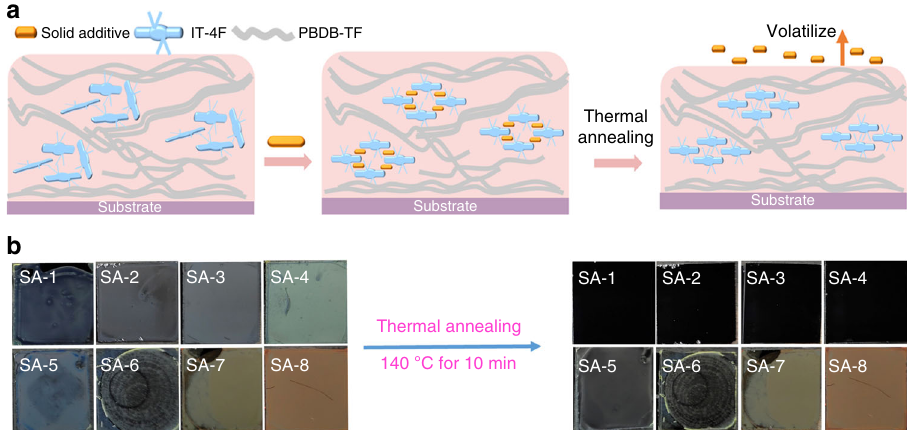
Fig. 4 Proposed mechanism of volatilizable SAs. a Schematic diagram of working mechanism of SAs. b Photographs of spin-coated fi lms of eight SAs. Then the fi lms were thermal annealed at 140 °C for 10